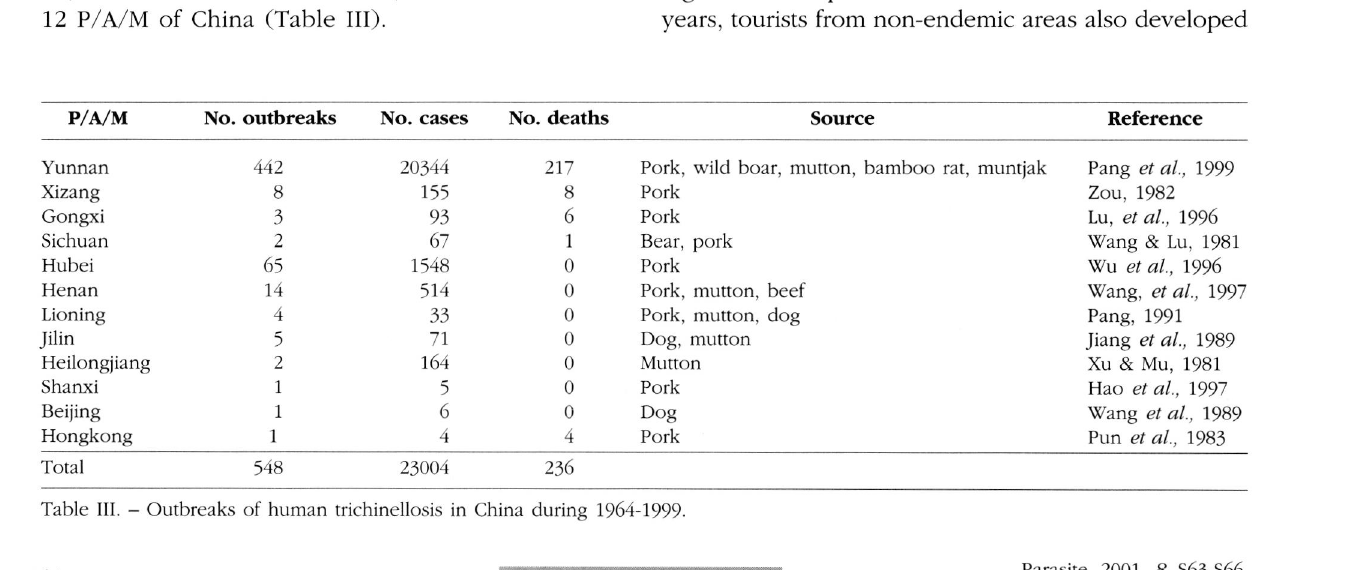
Table III. - Outbreaks of human trichinellosis in China during